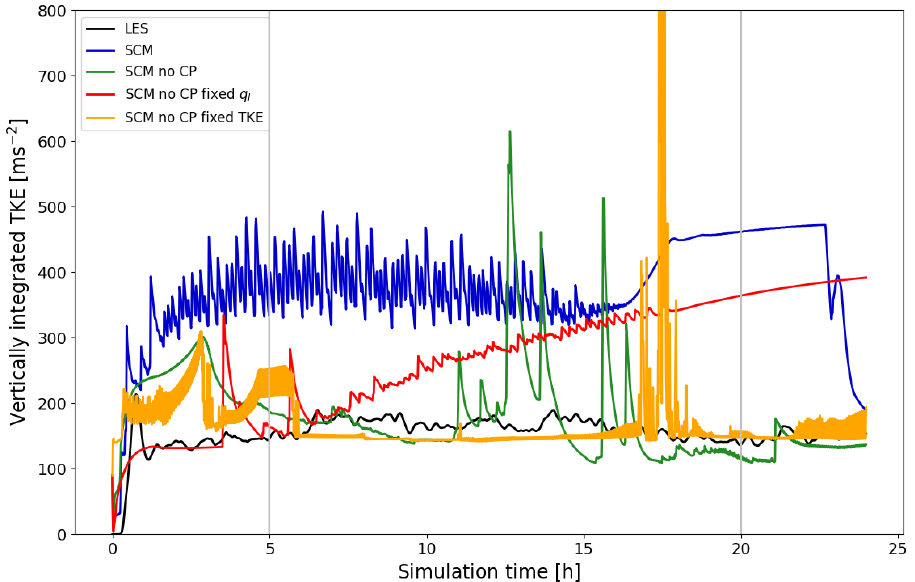
Figure 5. Temporal evolution of the vertically integrated TKE for the DYCOMS-II case. Comparison between LES (MicroHH) and ICON SCM simulations. Experiments executed without shallow convection parameterization are marked as “no CP”. Experiments with prescribed liquid water content and TKE are marked as “fixed q l ” and “fixed TKE”, respectively. Gray vertical lines indicate the time corresponding to the vertical profiles displayed in Figures 7 and